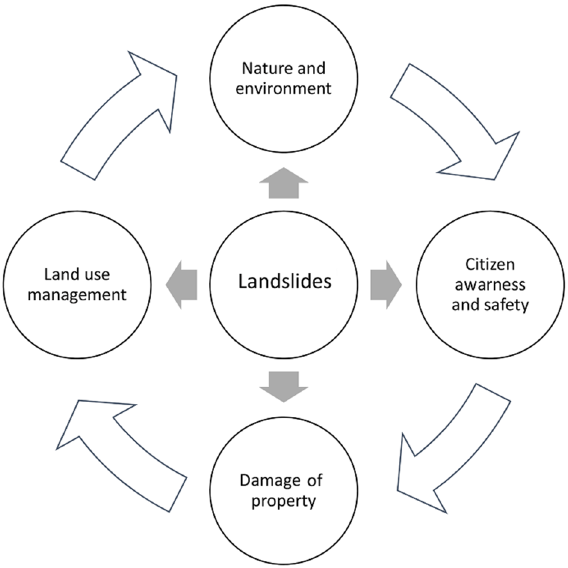
Figure 1. Landslides affect our environment and land use management and they can present dan- ger to properties and